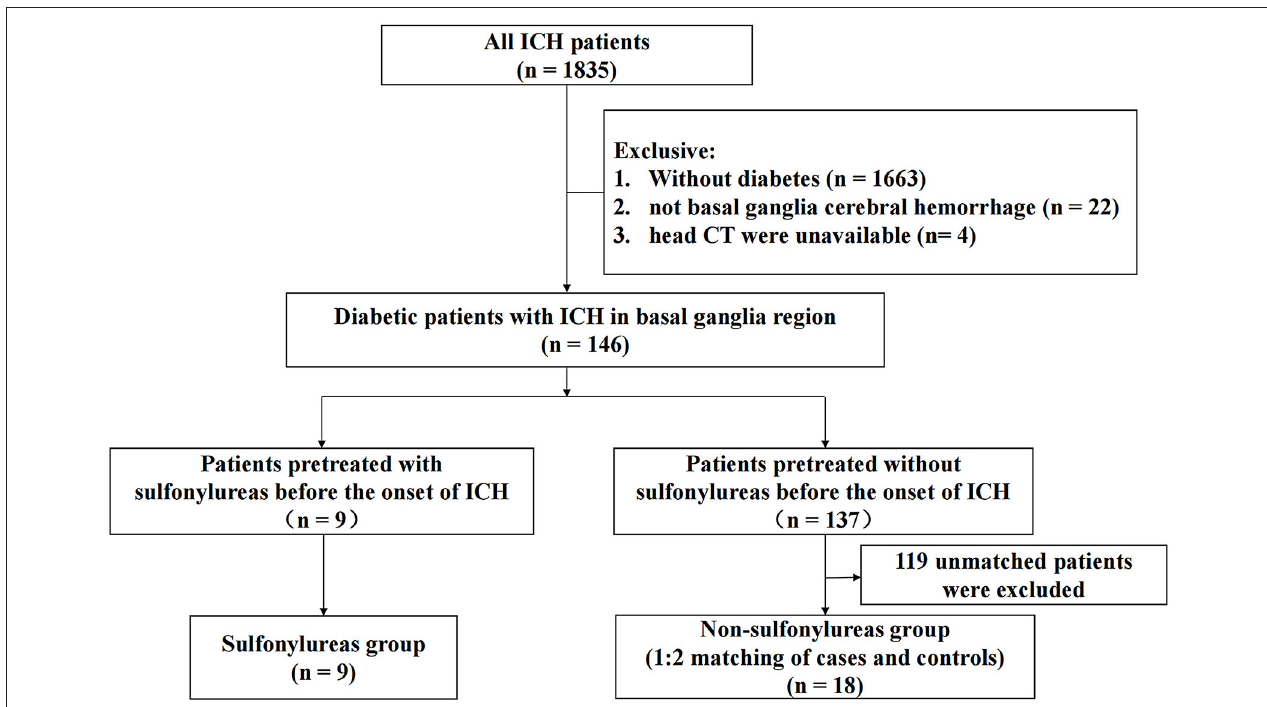
FIGURE 1 | Flow diagram of the included and excluded